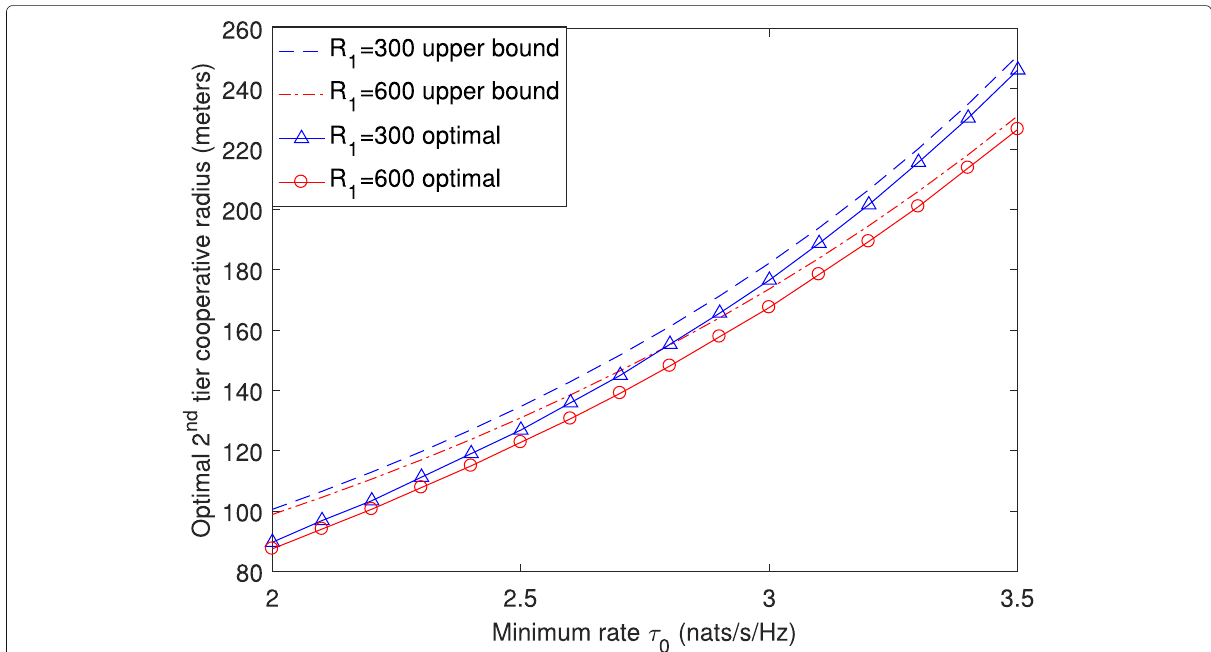
Fig. 7 The optimal cooperative radius as a function of the minimum rate with two different cooperative radii of the first tier